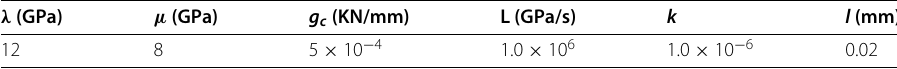
Table 2 Material properties used in the three-point bending fracture simulations, taken from (Miehe et al.